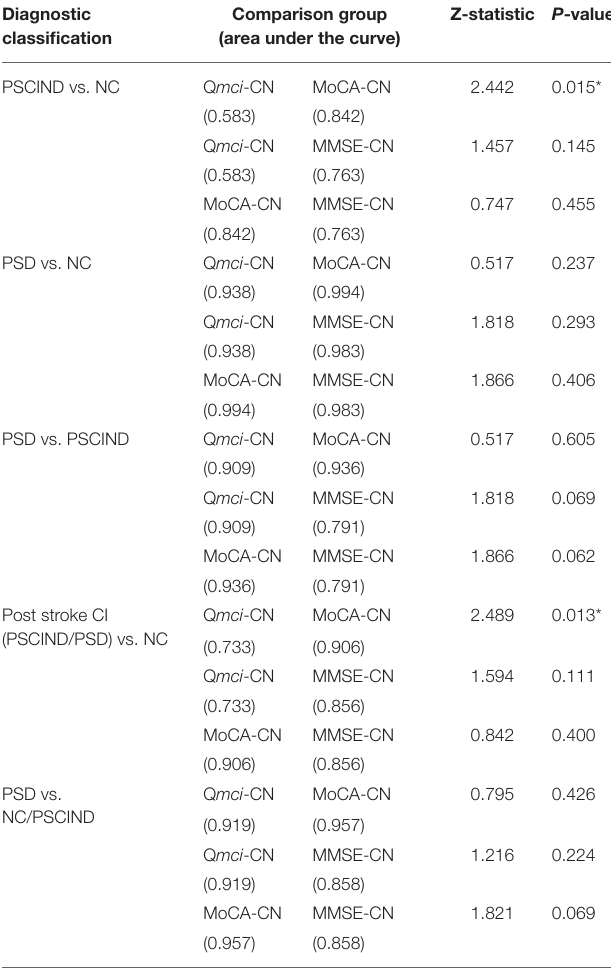
TABLE 5 | Pair-wise comparisons between the diagnostic accuracy of the Chinese versions of the quick mild cognitive impairment (Q mci -CN) screen, montreal cognitive assessment (MoCA-CN) and mini mental state examination